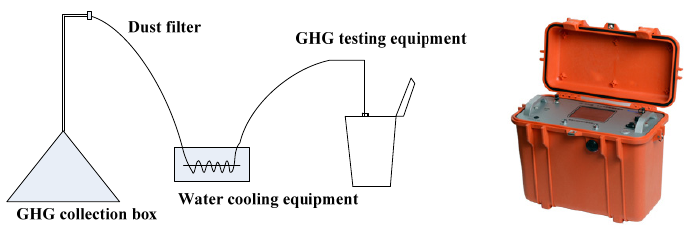
Figure 2. Schematic of GHG testing equipment and testing equipment.